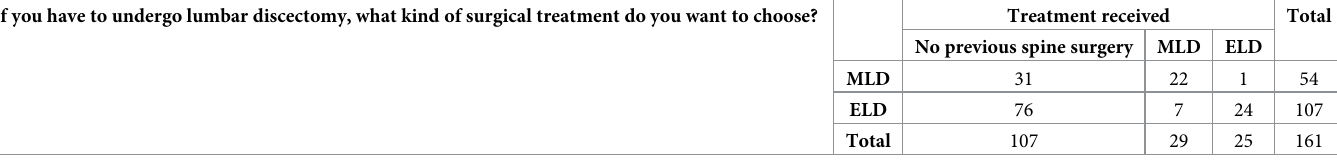
MLD, Microscopic Lumbar Discectomy; ELD, Endoscopic Lumbar